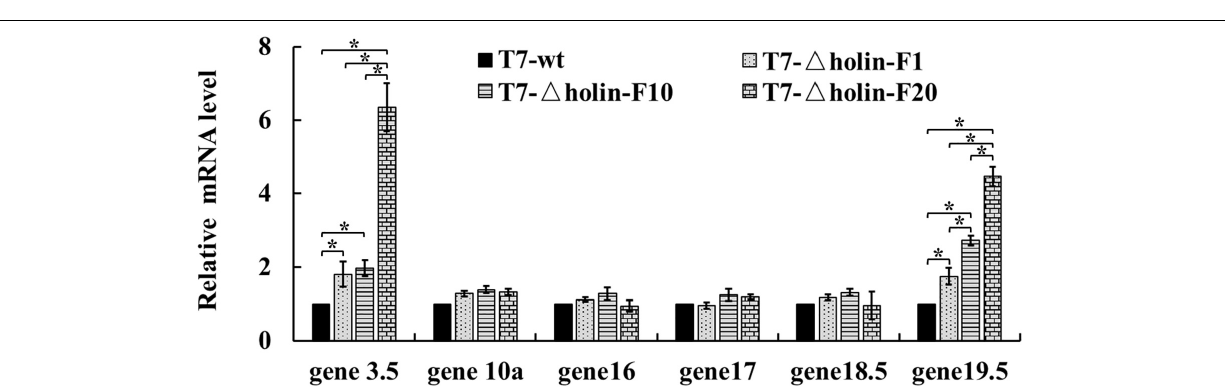
FIGURE 4 | Plaque enlargement assay of T7-wt and T7- (cid:52) holin. (A) Images of T7-wt and different generations of T7- (cid:52) holin phage plaques formed on a lawn of Escherichia coli BL21 host cells over a 16-h incubation period. (B) The plaque diameter of T7-wt and T7- (cid:52) holin phages formed on a lawn of E. coli BL21 host cells over a 16-h incubation period.